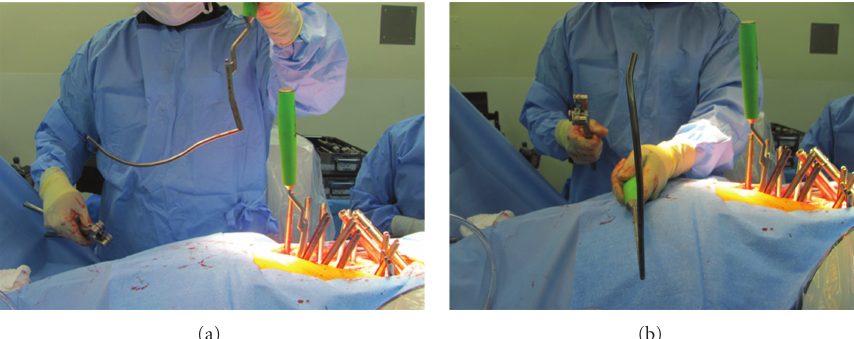
Figure 5: Two plane rods bending in the (a) sagittal and (b) coronal planes to facilitate connection to the more laterally located iliac screw